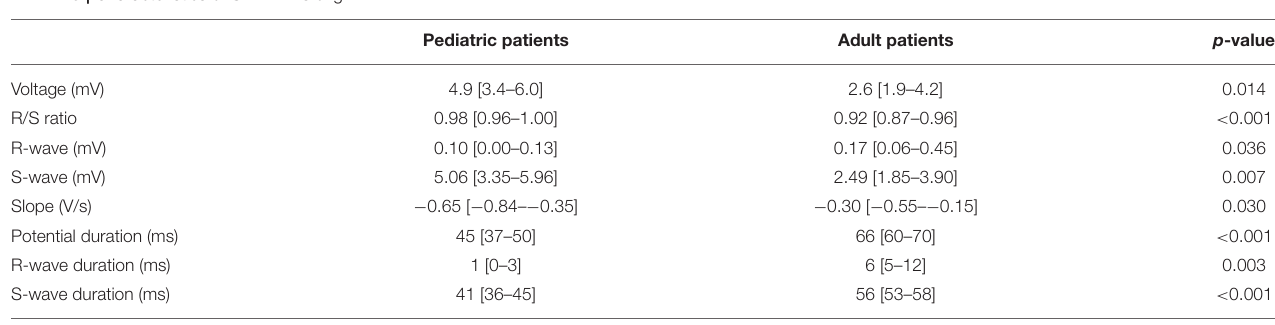
TABLE 3 | Characteristics of SAN-FAPs